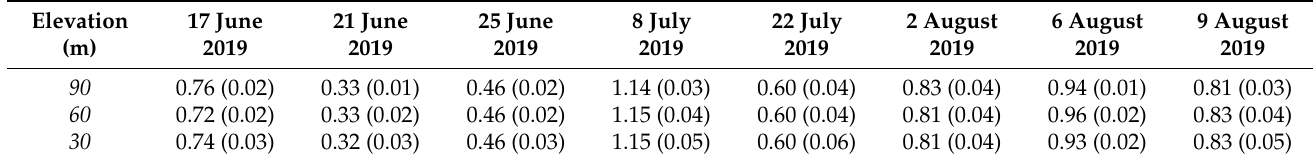
Figure 6. HRMET ET (mm h − 1 ) raster maps for each mission. Table 3. HRMET ET estimates (mm h − 1 ) across the flight domain.